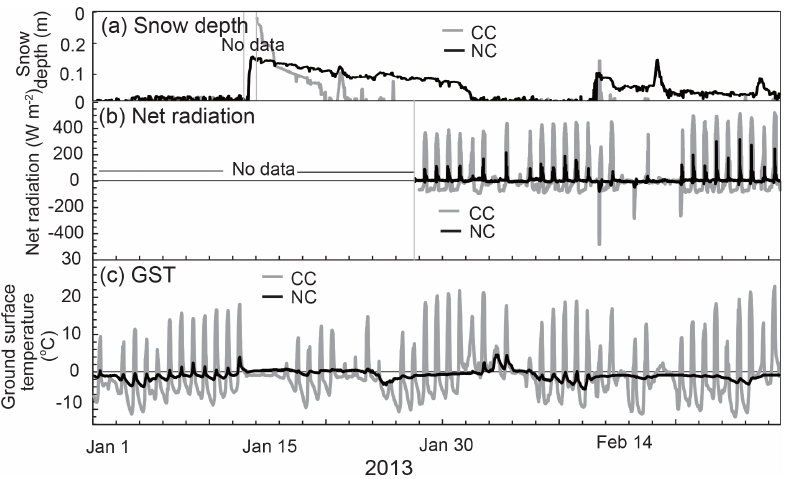
Figure 5. Comparison of microclimate conditions between sites CC and NC in winter (1 January to 28 February 2013). (a) Snow depth measured by ultrasonic sensors at sites CC (CCR) and NC (NCR). (b) Net radiation measured by net radiometers in sites CC (CCS) and NC (NCS). (c) Ground surface temperature (GST) in sites CC (CCS) and NC (NCS).